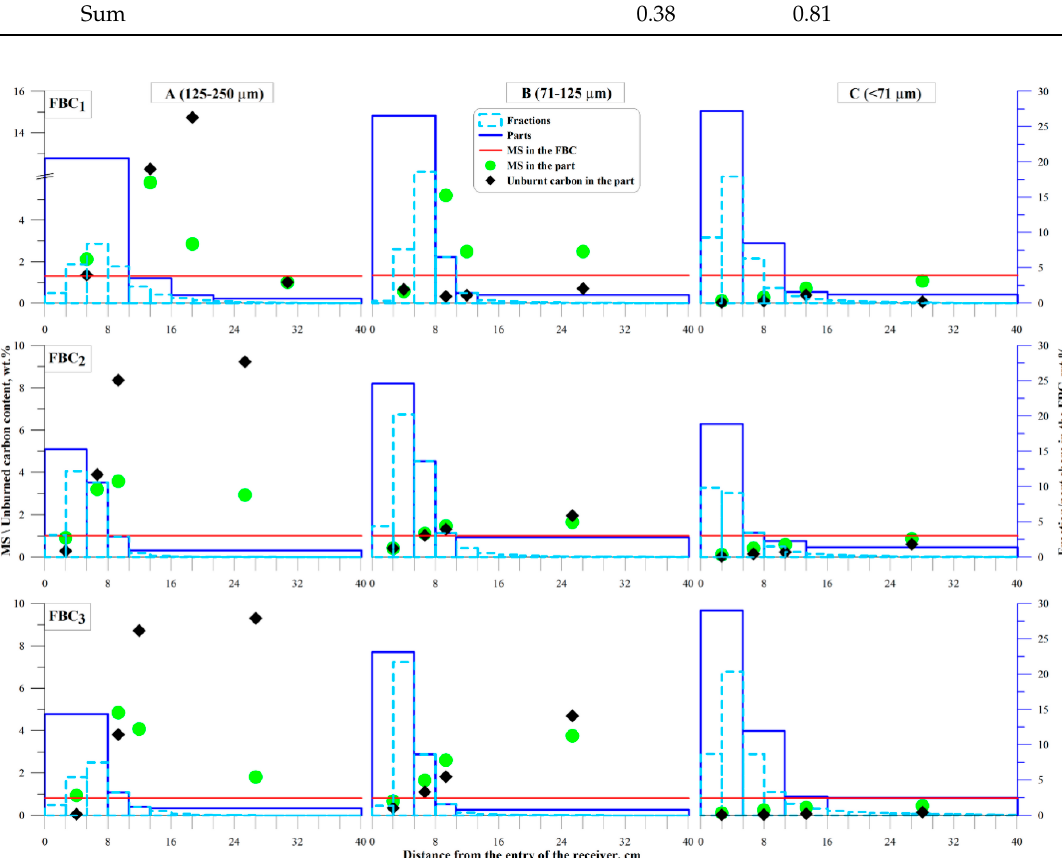
Figure 4. Fluidised bed concentrates (FBCs) pneumatic separation summary.